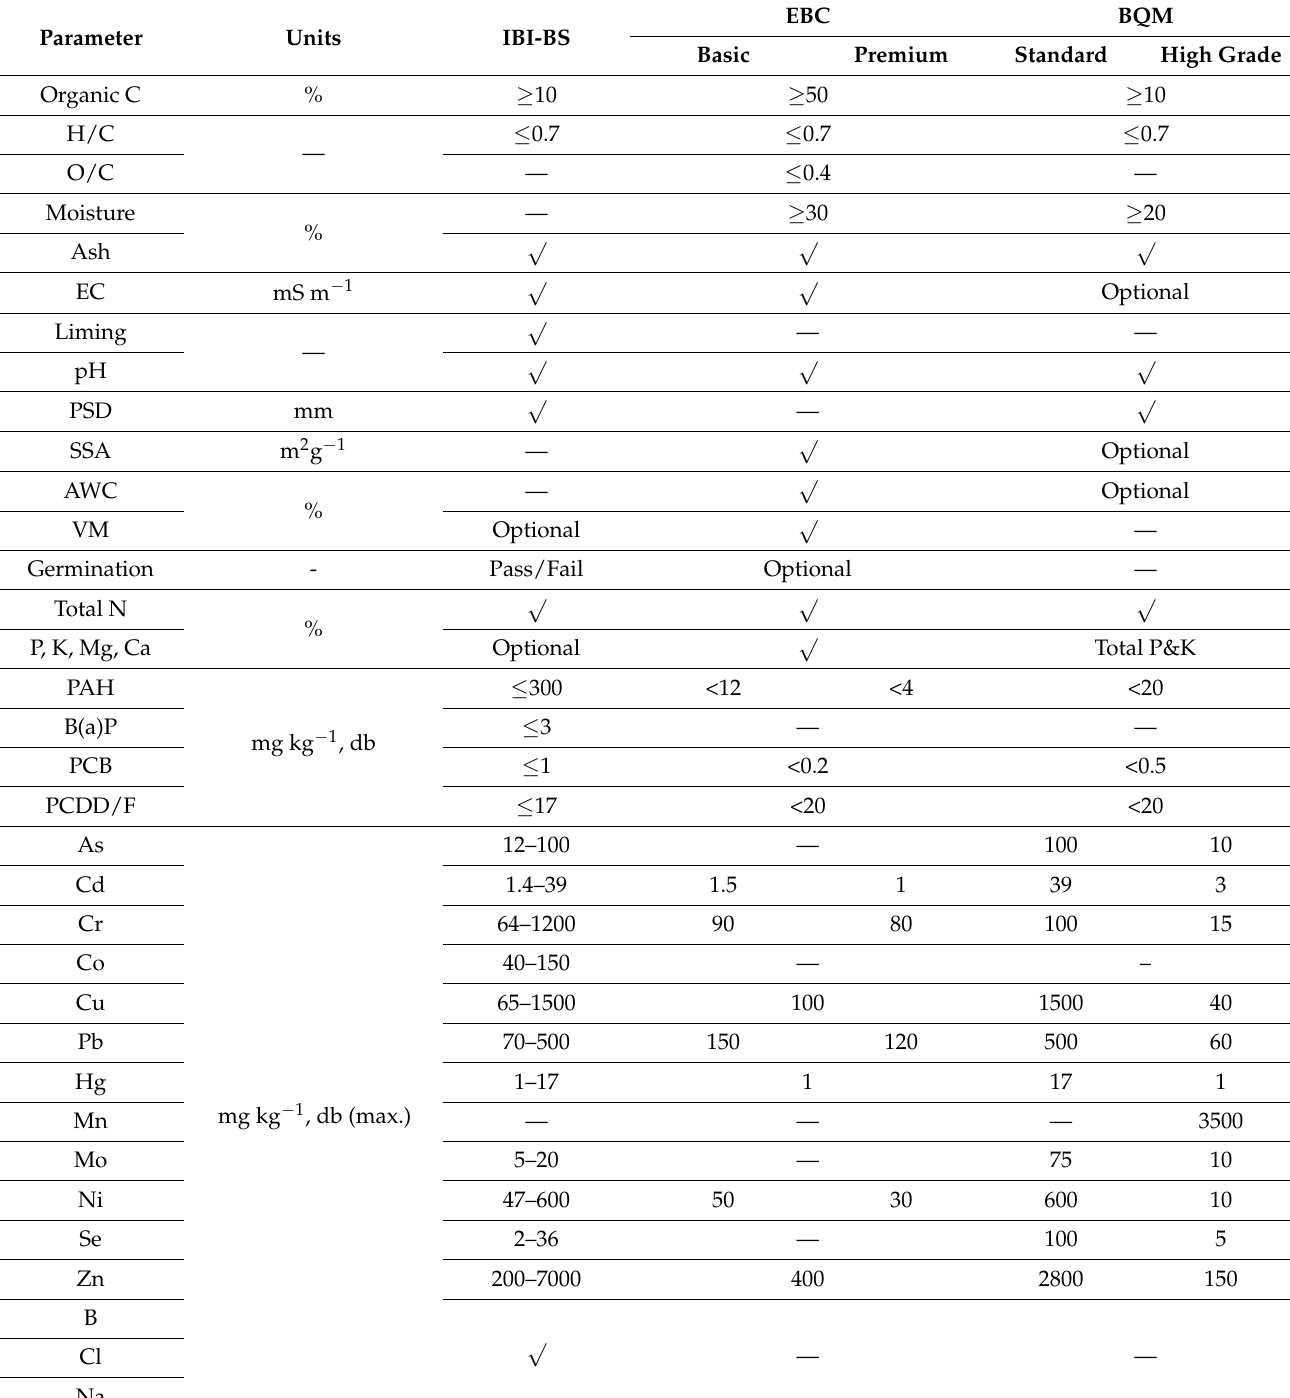
Table 8. Overview of biochar certification schemes